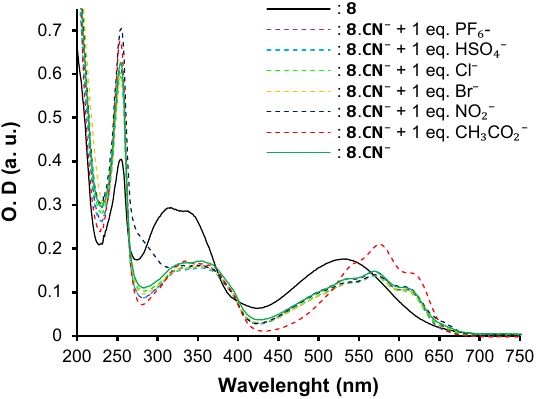
Figure 11. UV–Vis Job-plot for 8.CN − , [ 8 ] 0 + [CN − ] 0 = ca 1.40 × 10 − 5 M. Association constants K i were determined by solving the nonlinear equations given in literature [45]. For instance, for complex [1:1], [H 0 ] = [H] + [G], [G 0 ] = [G] + [HG] and K 1 [H].[G] = [HG]; for complex [1:2], [H 0 ] = [H] + [G] + [HG], [G 0 ] = [G] + [HG] + [HG 2 ], K 1 [H].[G] = [HG], and K 2 [HG].[H] = [HG 2 ] (where H corresponds to the host, G the guest, and the subscript 0 denotes the initial concentration for each species). The total absorbance is given by the equation A = ε H [H] + ε HG [HG]+ ε HG 2 [HG 2 ] + ε G [G], where ε corresponds to the molar extinction coefficient for each species. Hence, the determination of the asso- ciation constants K 1 gives the following trend K CH3CO2 − >> K CN − > K NO ₂− (Table 3), which is in good agreement with the experimental optical changes observed in UV–Vis spectra. In addition, based on the equilibrium constants and ε , we are able to predict a reasonable titration theoretical spectrum (Figure 12) matching with the experimental data.